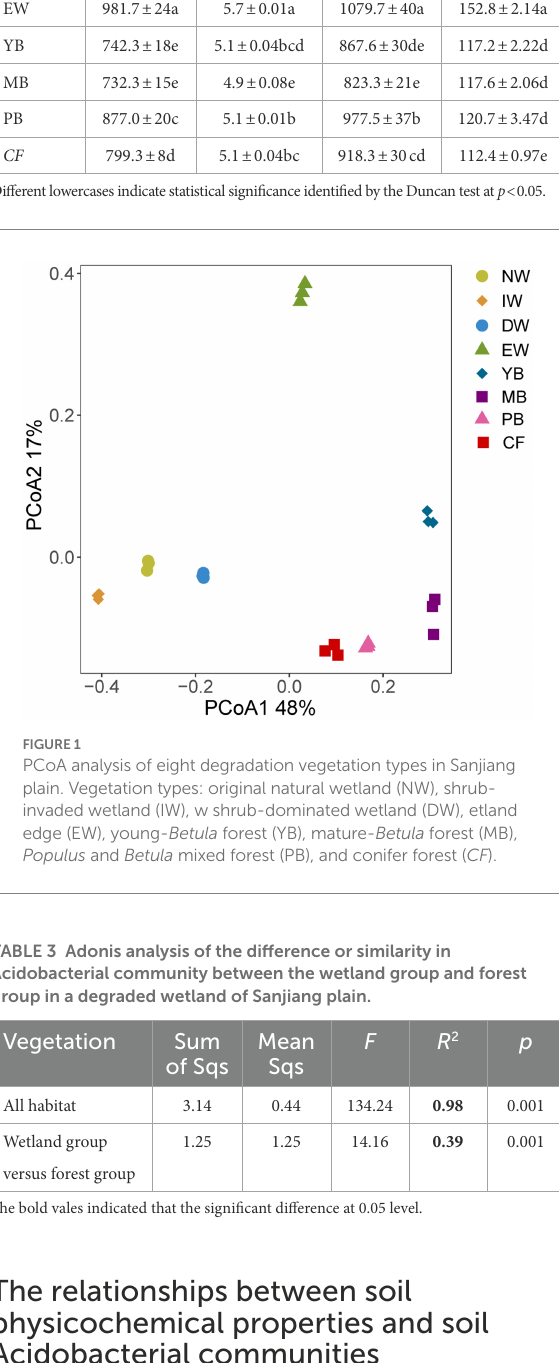
Mantel tests (Table 4) indicated that soil AP and MC were the key soil physicochemical properties affecting the soil